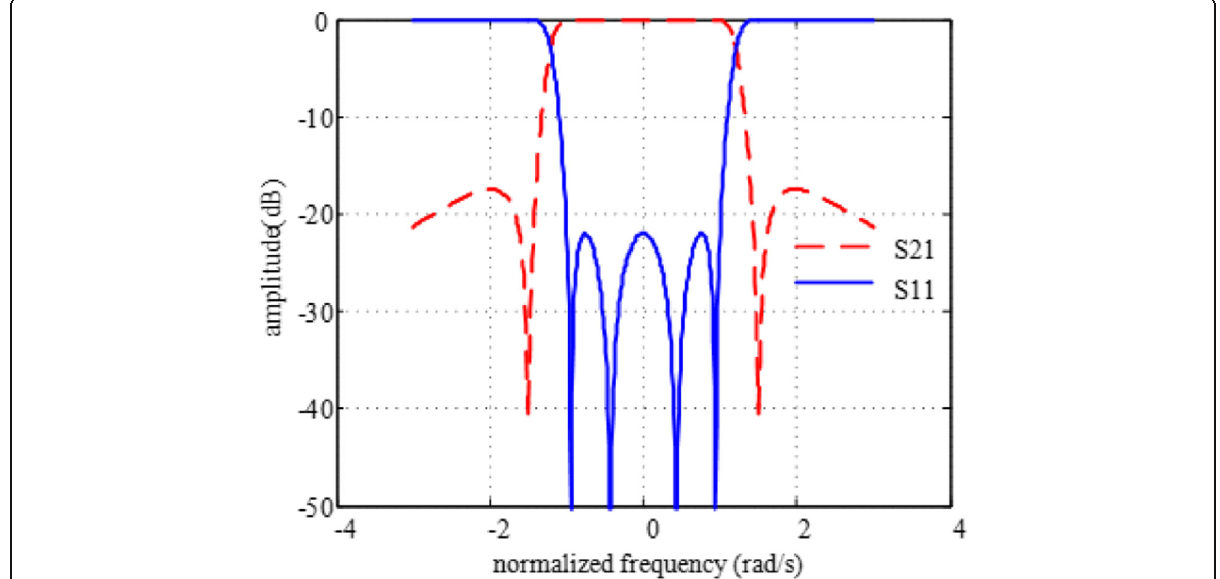
Fig. 3 S parameters curve of four-order single-passband